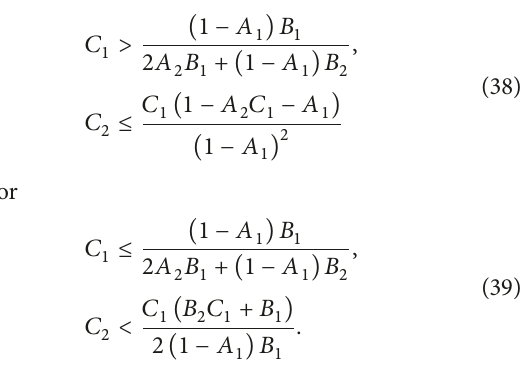
𝐶 = (𝐵 𝐶 + 𝐵 ) 2 /(4𝐵 (𝐴 𝐵 + (1 − 𝐴 )𝐵 2 2 1 1 1 2 1 1 2